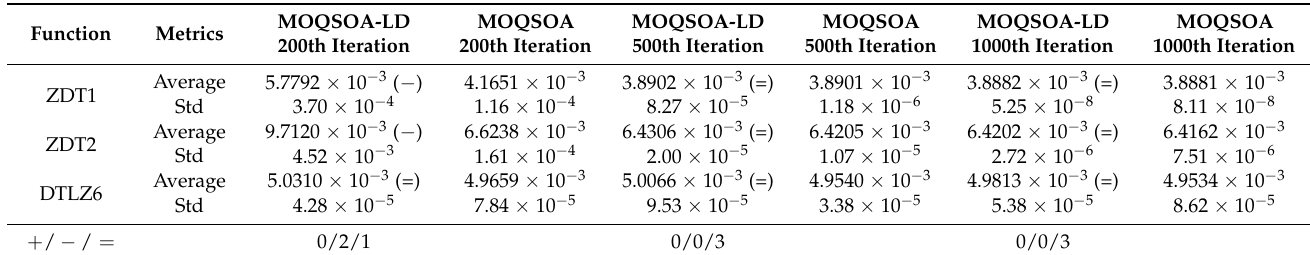
Table 6. Results influenced with nonlinear migration